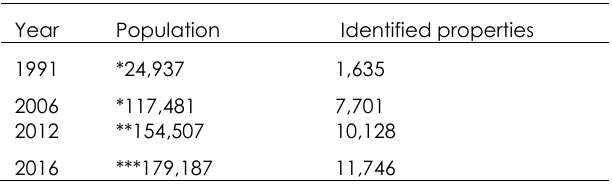
Table 1. Housing population in the study area between years 1991-